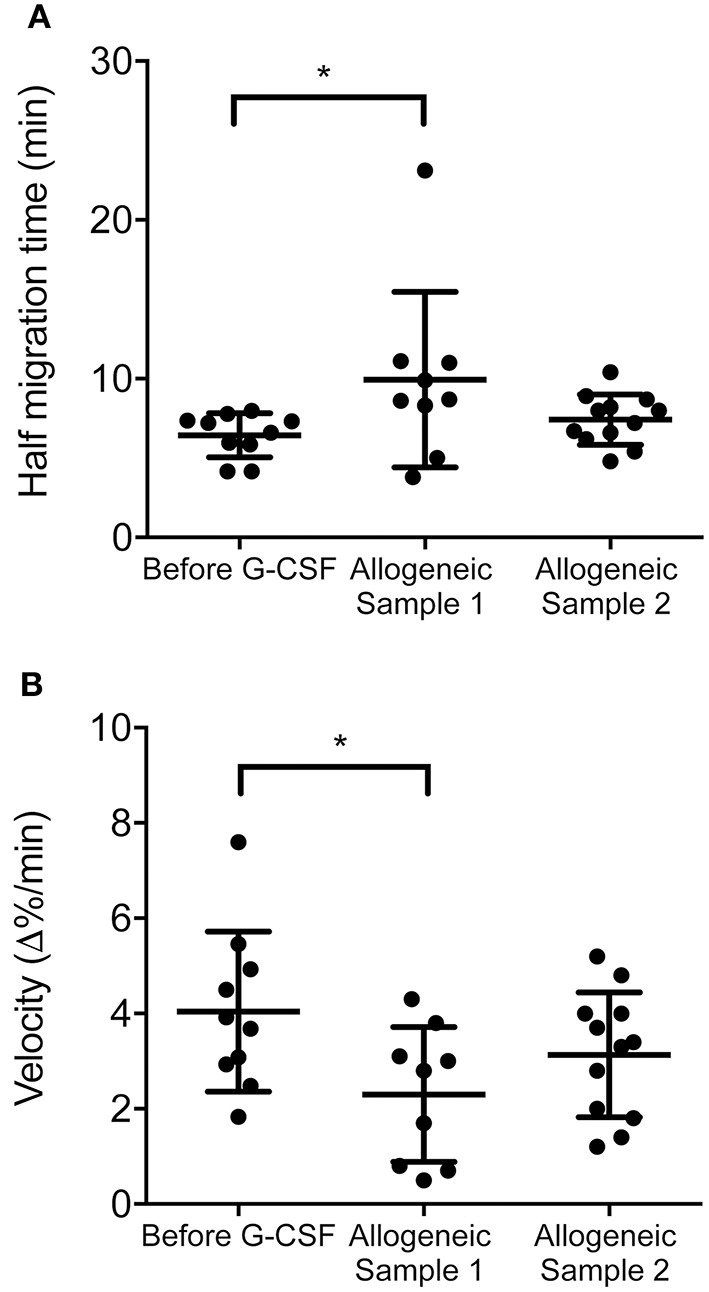
The chemotactic activity remains impaired in allogeneic transplant recipients. (A) Distribution of half migration time in the stem cell donors before G-CSF treatment (n = 10), serving as controls, and samples from patients undergoing allogeneic stem cell transplantation at a medium of 48.9 days (n = 9), indicated as sample 1, and 80.2 days (n = 12), indicated as sample 2, after transplant, respectively. The half migration time is measured as the time it takes to reach half of max fluorescent and is a measure of neutrophil speed in the process of chemotaxis. (B) The distribution of velocity during chemotaxis comparing stem cell donors before G-CSF with samples from patients undergoing allogeneic stem cell transplantation as described above. The evaluation shows that the velocity at half max migration goes down early after allogeneic stem cell transplantation which confirms that the chemotaxis in neutrophils is slower early after stem cell transplantation. Statistical analysis was performed with a Kruskal–Wallis test for (A) (p = 0.0466) and (B) (p = complemented with Mann–Whitney U-tests showing that samples “before G-CSF treatment” and “allogeneic sample 1” are significantly different for (A,B) with *p < 0.05.